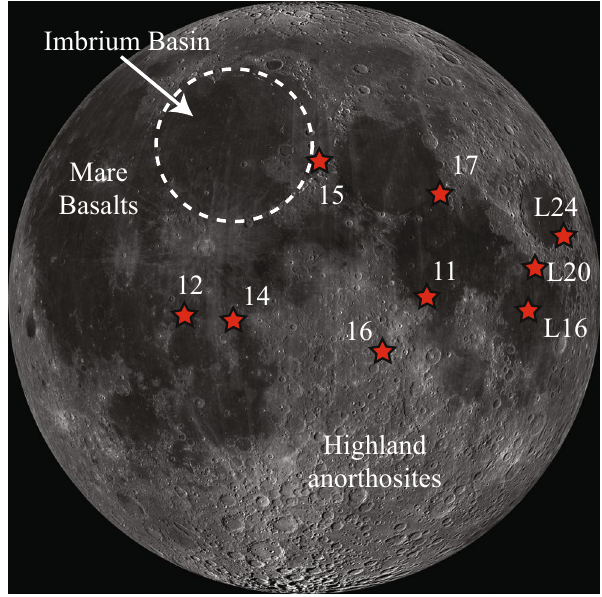
Figure 1. Sample collection context map. Lunar Reconnaissance Orbiter (LRO) Wide Angle Camera (WAC) mosaic (Image from the LROC PDS archive: NASA/GSFC/Arizona State University) of the lunar nearside, showing dark mare basalts and the higher albedo highland rocks. Stars represent the location of the Apollo and Luna (L) mission landing sites. Dashed circle marks the estimated limit of the rim of the Imbrium